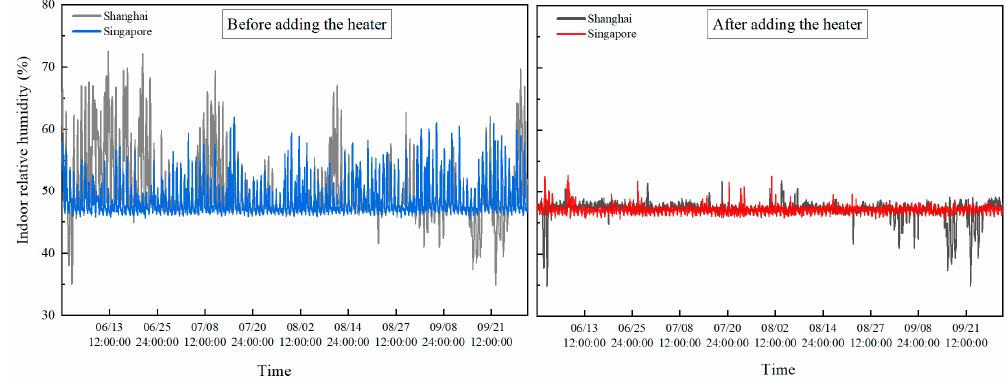
Figure 17. Indoor relative humidity before and after adding the heater in system B.